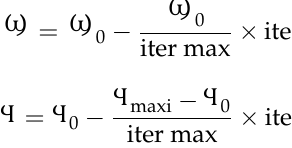
Algorithm 3 DPSAC ‐ based UAV positioning.